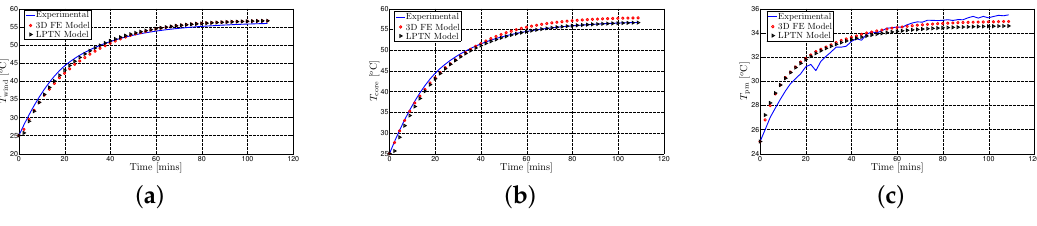
Figure 11. Machine ( a ) winding temperature; ( b ) core temperature; ( c ) PM temperature. FE: finite